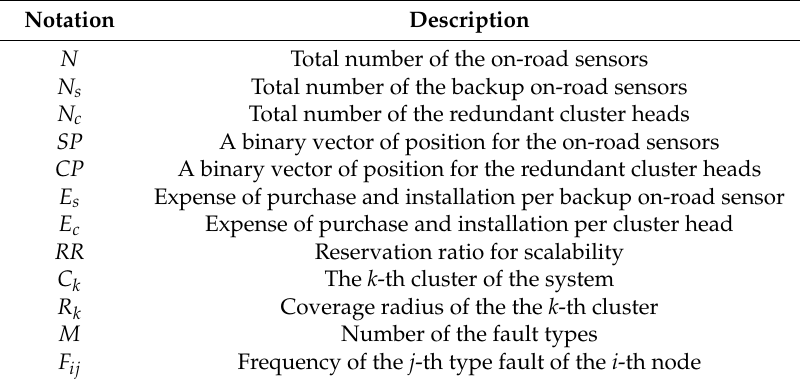
Table 1. Notations used in this